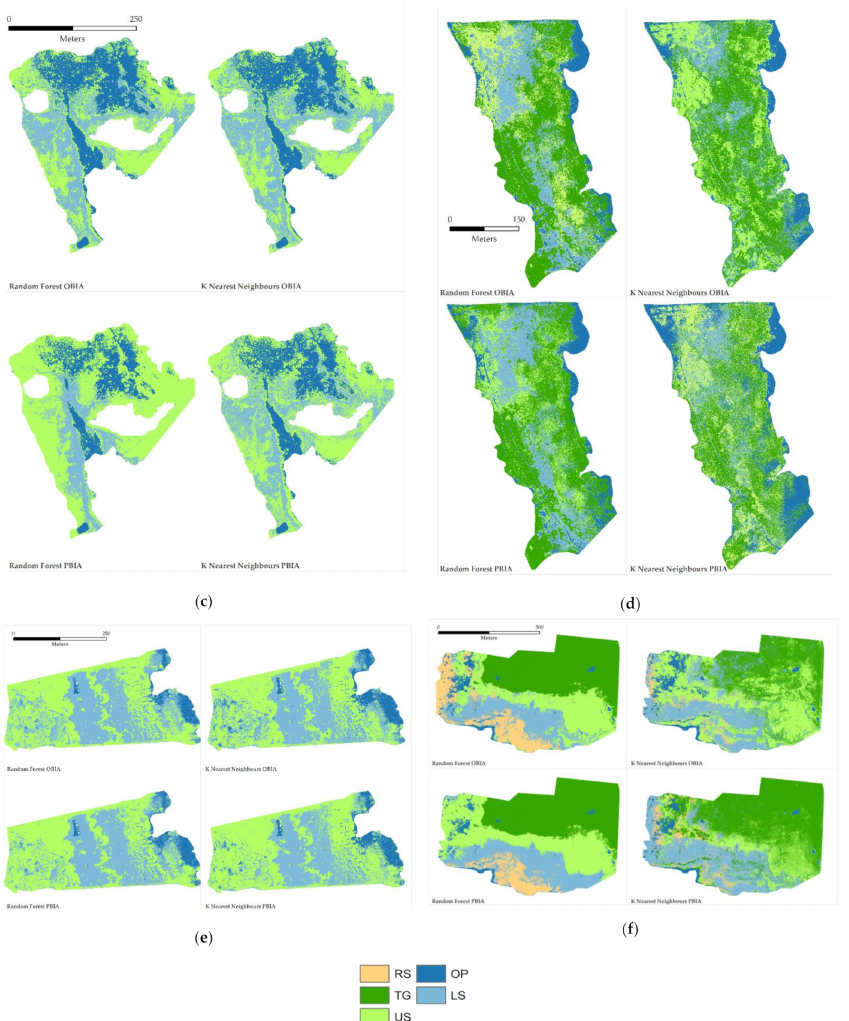
Figure A1. Plant community classification for each study area with the legend (below all the maps). ( a ) Kudani, ( b ) Ralby, ( c ) Rumpo East, ( d ) Tahu South, ( e ) Tahu North and ( f )